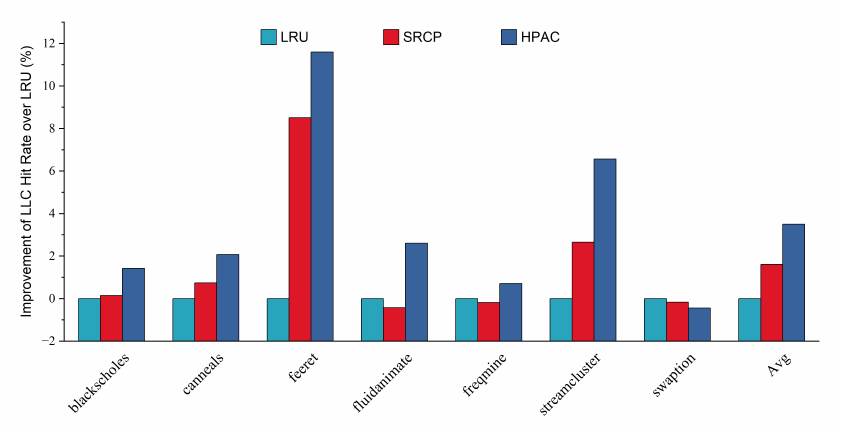
Figure 8. Improvement of hit rate over baseline LRU.